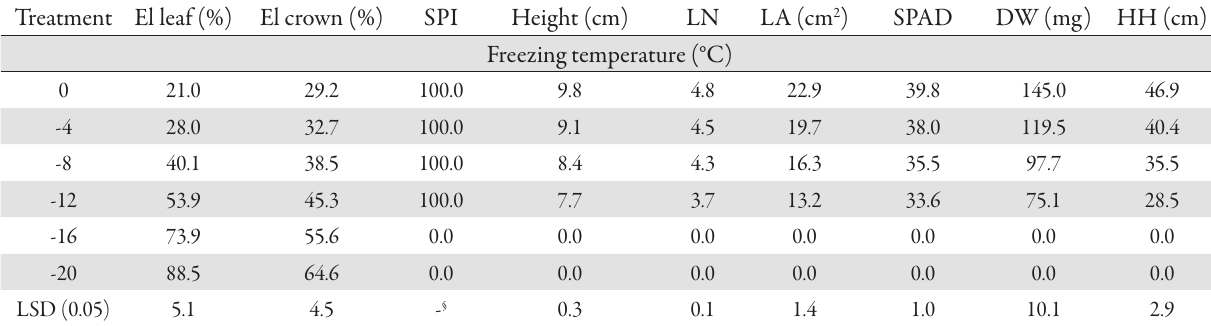
Tab. 3. Freezing temperature effects on various measured plant parameters Treatment El leaf